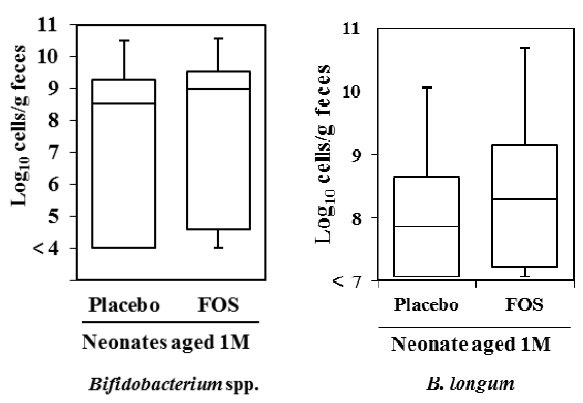
Figure 3. Infant fecal Bifidobacterium spp. and B. longum at one month of age, excluding neonates born by C ‐ section. The number of Bifidobacterium spp. was quantified using q ‐ RT ‐ PCR ( n = 25 and 30 in the analysis of B. longum ) for the placebo and FOS group, respectively). Box and whiskers plot, with the black horizontal line representing the median value and the boxes the interquartile ranges. The T ‐ bars represent the data range, and the open circles indicate the presence of outliers (data points more than 1.5 interquartile ranges below the first quartile or above the third quartile). No significant difference was observed between the groups (Mann ‐ Whitney U test).